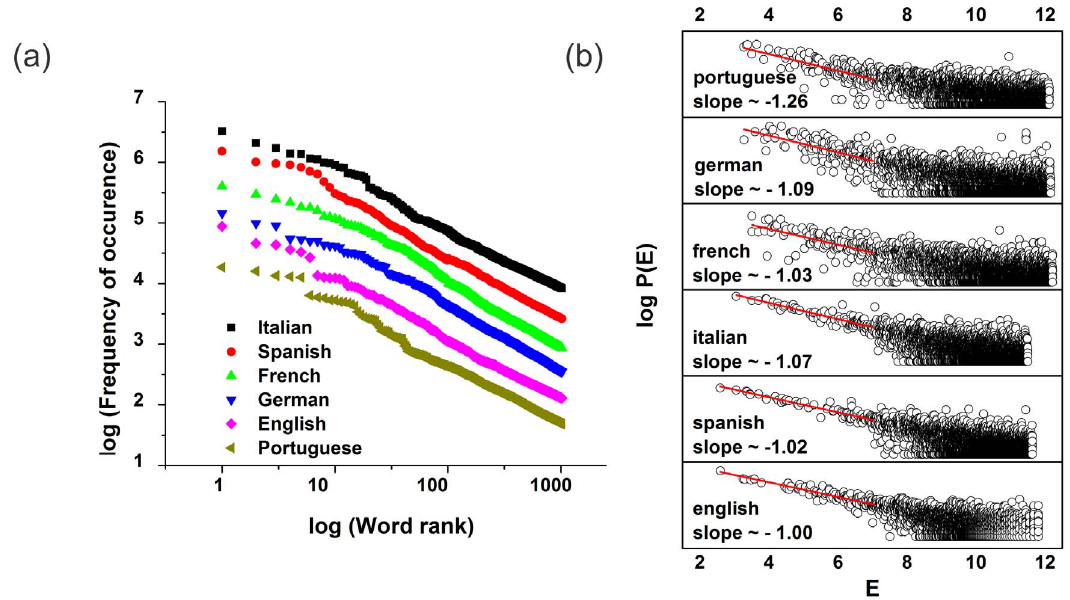
Figure 2. Comparison between the Zipf scaling and the comparative thermo-linguistic technique for several languages. Languages comparision for: (a) a log-log plot exibiting the Zipf law (all curves has similar slopes) in the probability distribution P ( r ) of ocurrency for the 1024 most frequent words in the corpus according the ‘‘Project Gutenberg’’; (b) and a log plot of the probability distribution P ( E ) of the word energies in the book Da Vinci Code by Dan Brown, exibiting the different slopes, therefore different temperatures. (Note that the y axis in both graphics are shifted for better visualization).